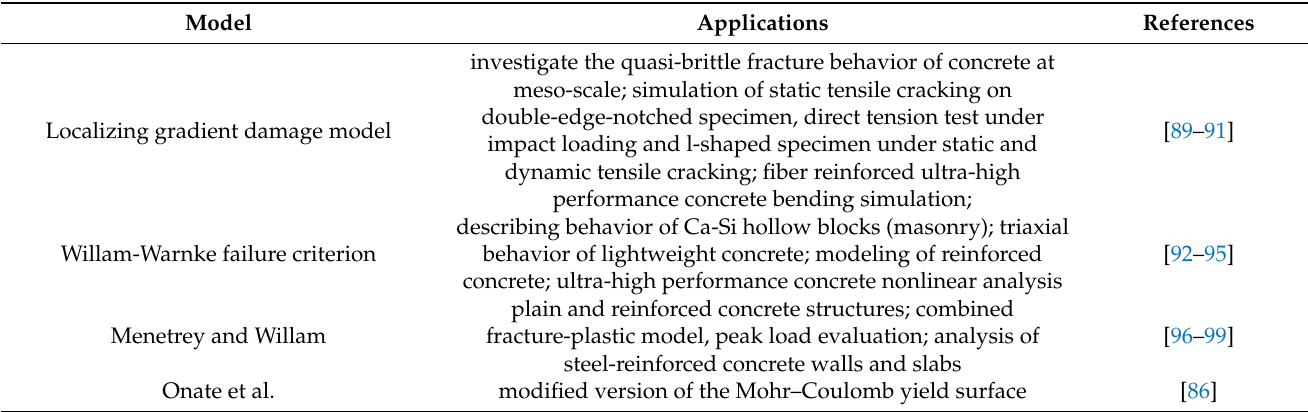
Table 1. Examples of complex constitutive models used for cementitious materials.